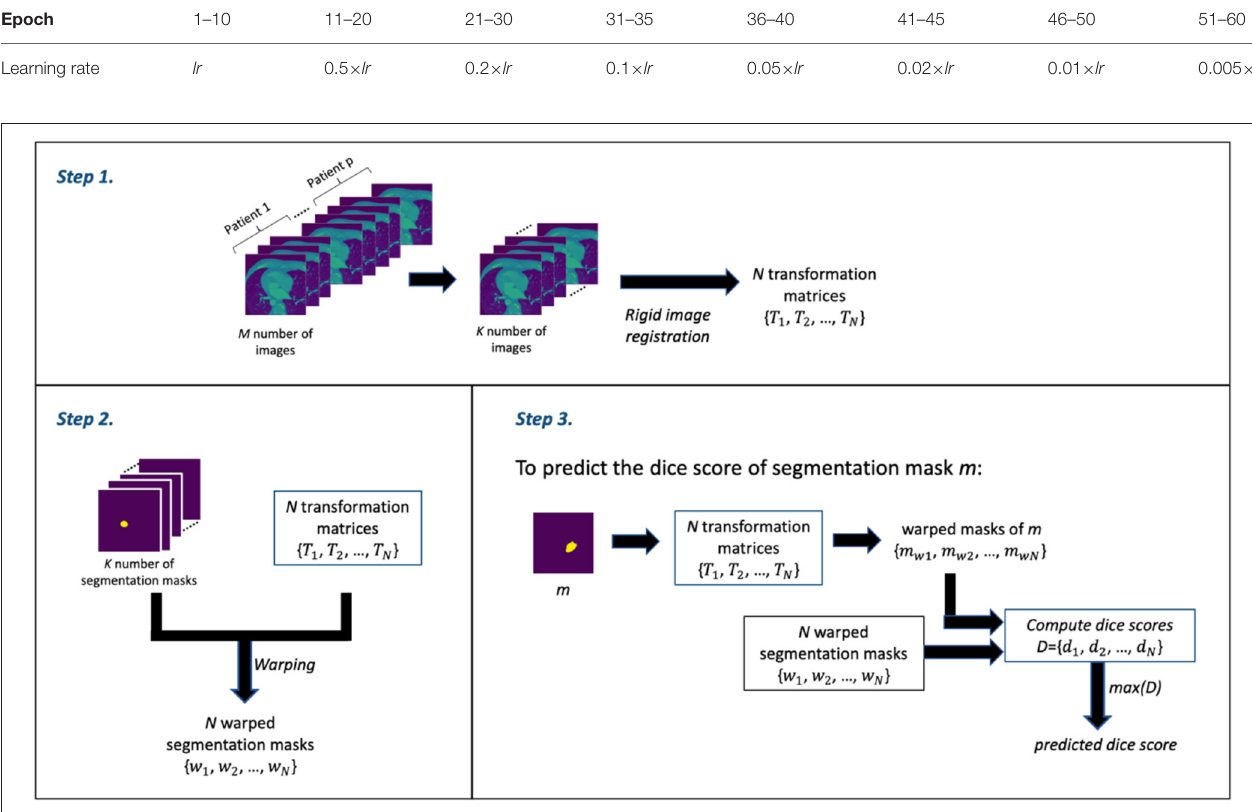
FIGURE 2 | The three steps of the Modified Reverse Classification Accuracy (mRCA)